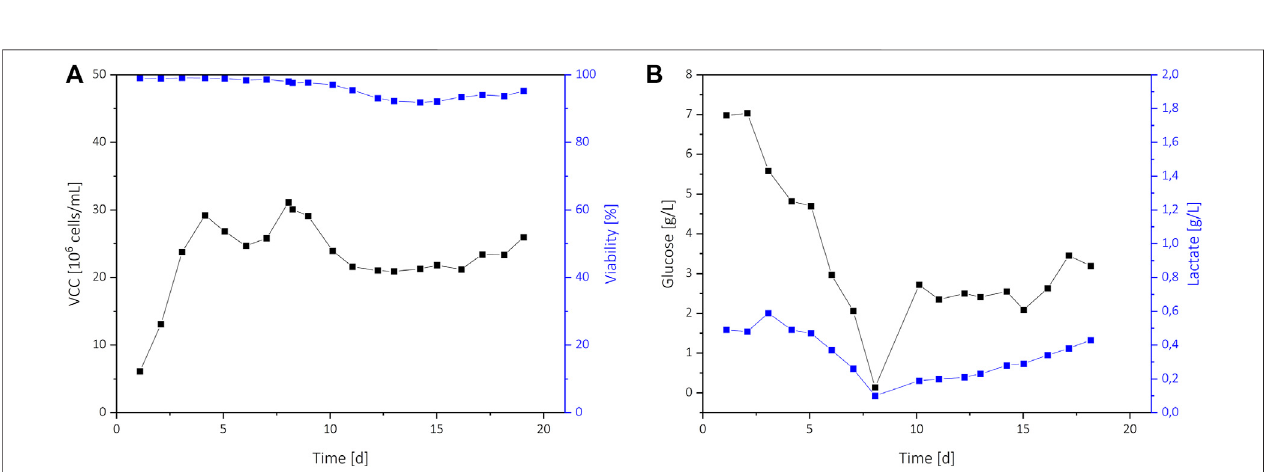
FIGURE 3 | Process data of the N-stage perfusion C5 where a continuous cell bleed was implemented. The VCD and viability (A) , and the glucose and lactate concentrations (B) are shown.